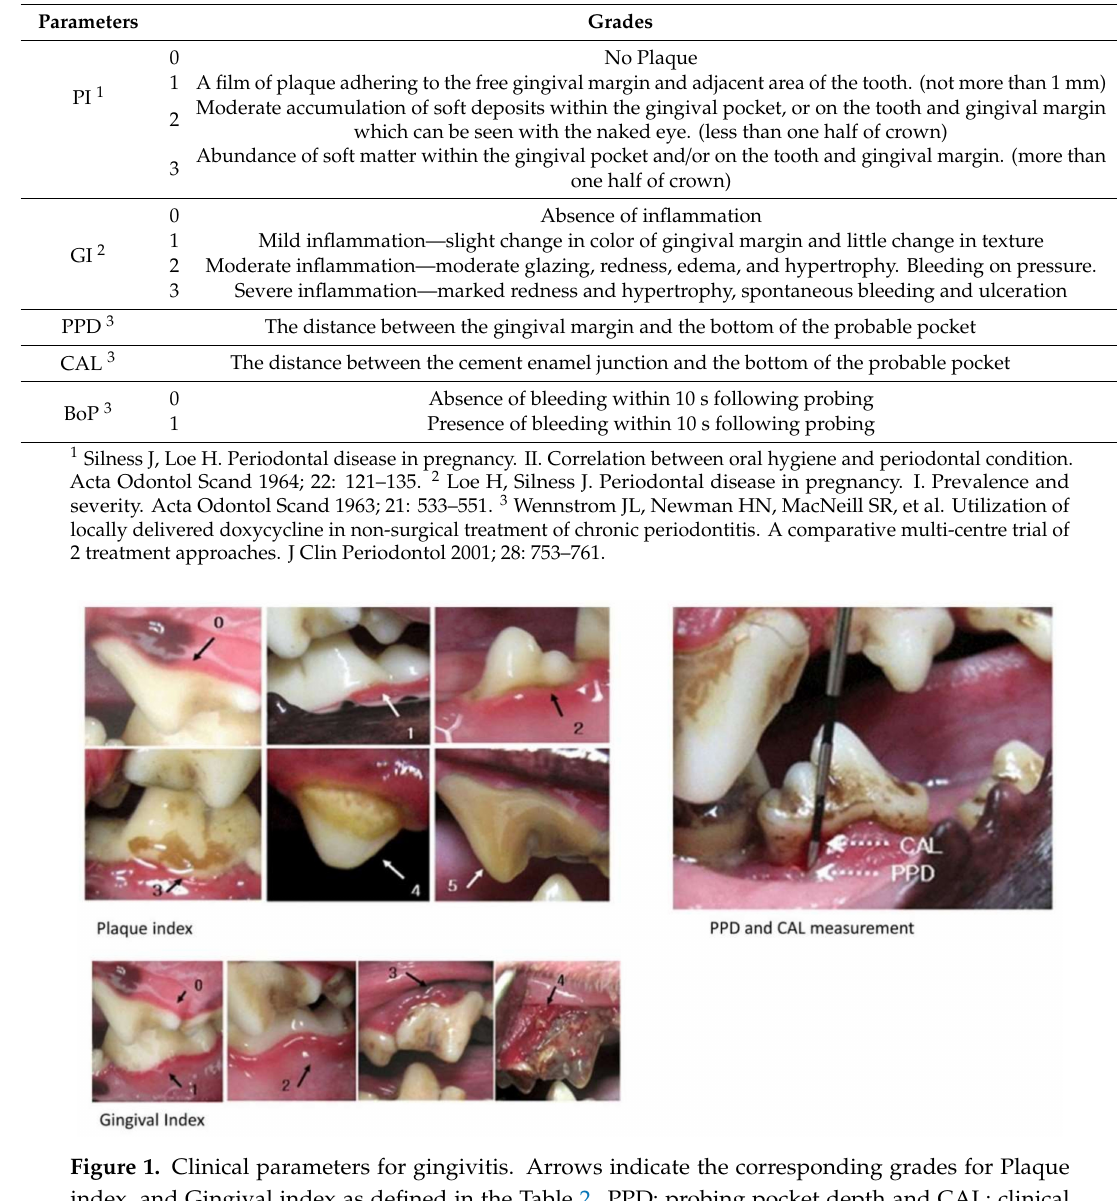
Table 2. Clinical parameters (Figure 1).